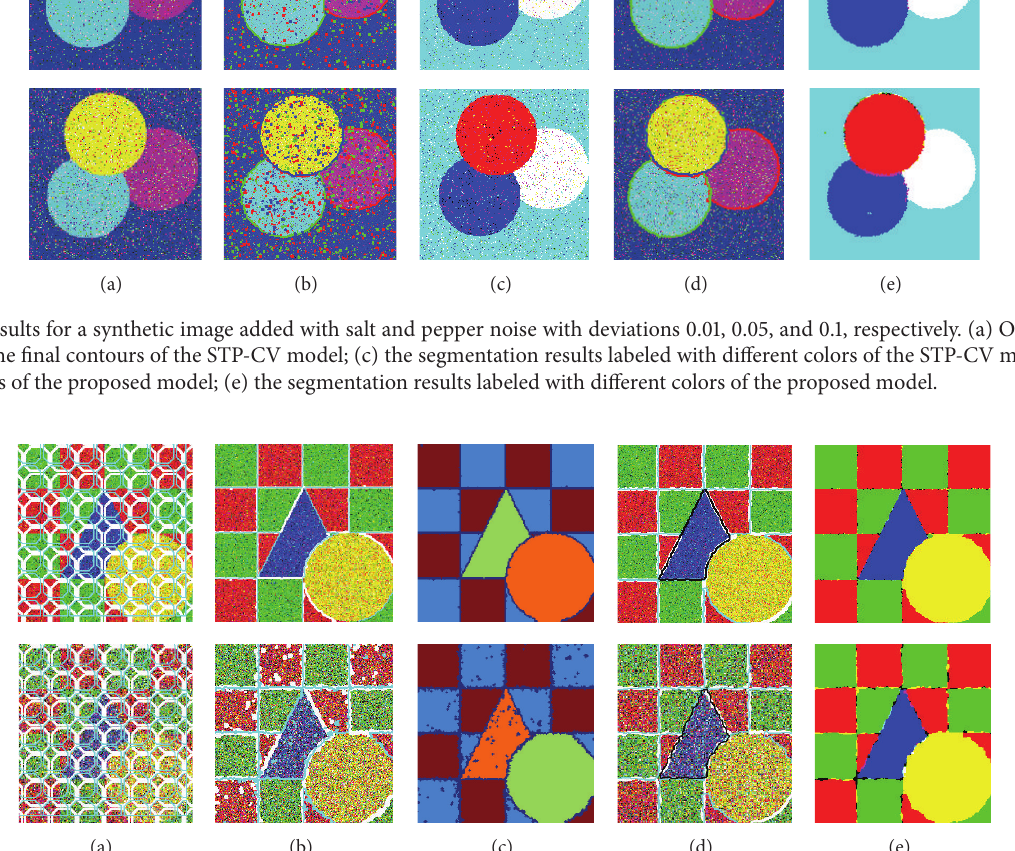
in each channel independently. The final segmentation results are obtained through MSC